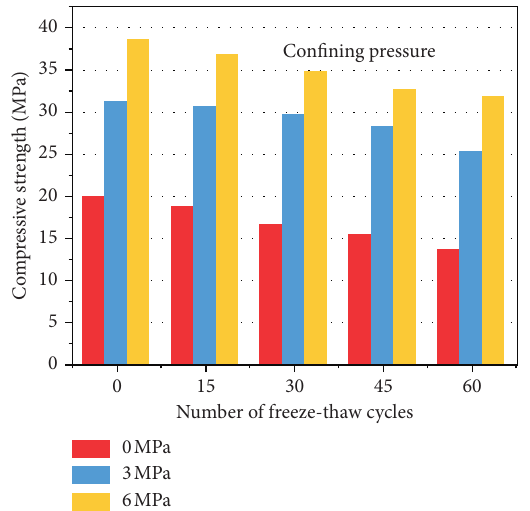
Figure 8: The relationship between compressive strength and the number of freeze-thaw cycles in uniaxial compression tests and peri-pressures of 3 and 6MPa,